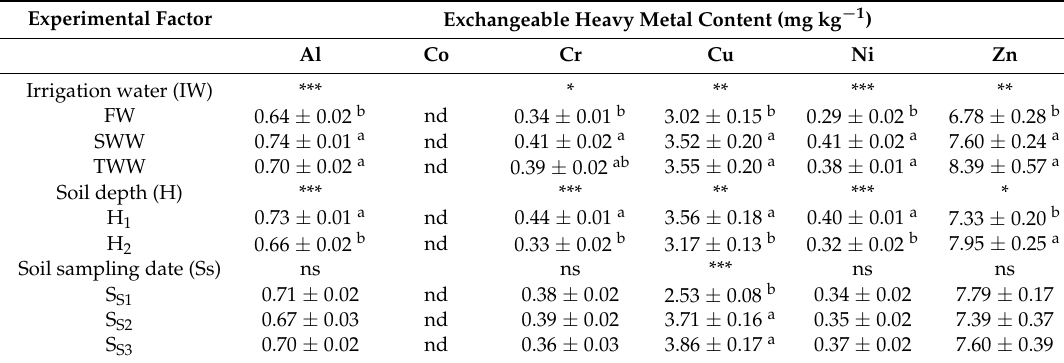
Table 3. Main effects of irrigation waters, soil depths, and soil sampling dates on the exchangeable soil heavy metal contents (after DTPA